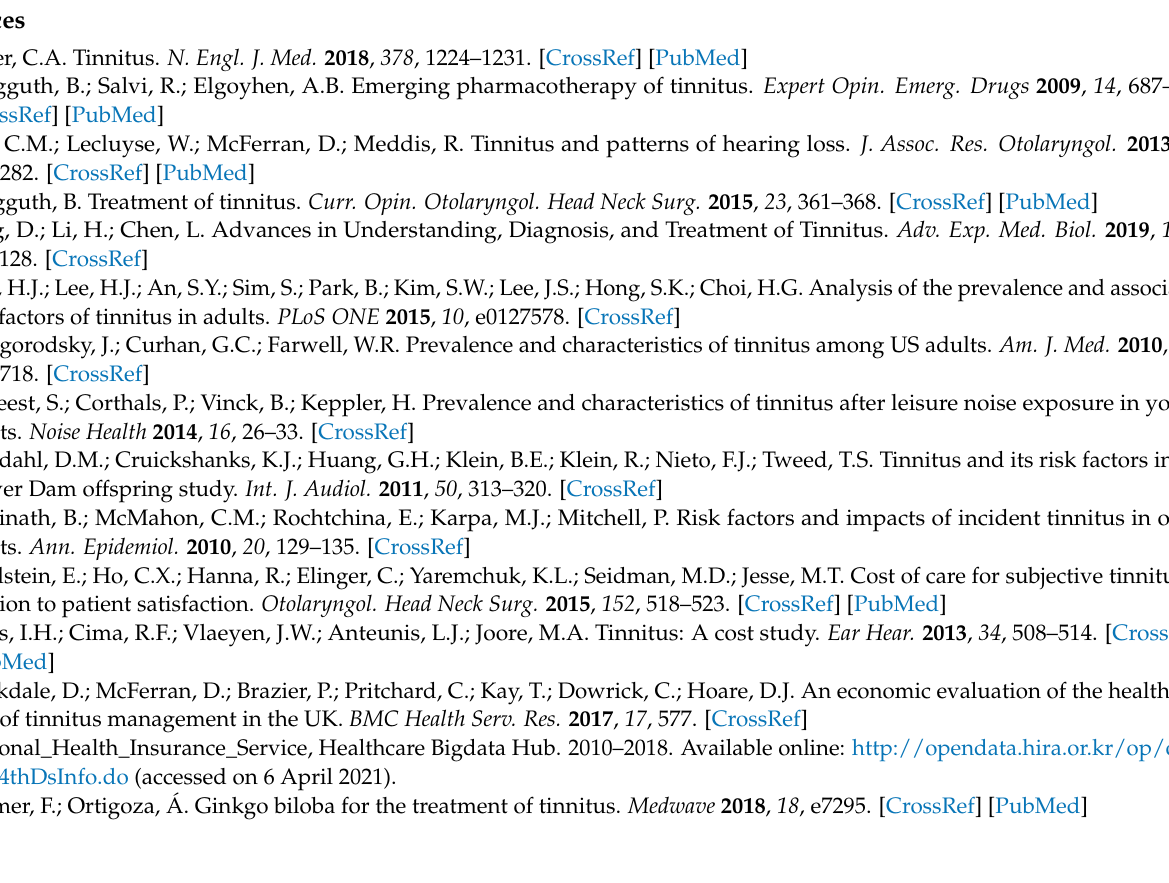
Table S3: High-frequency care for tinnitus in WM, Table S4: High-frequency care for tinnitus in KM, Figure S1: Yearly trend in the prescription of other